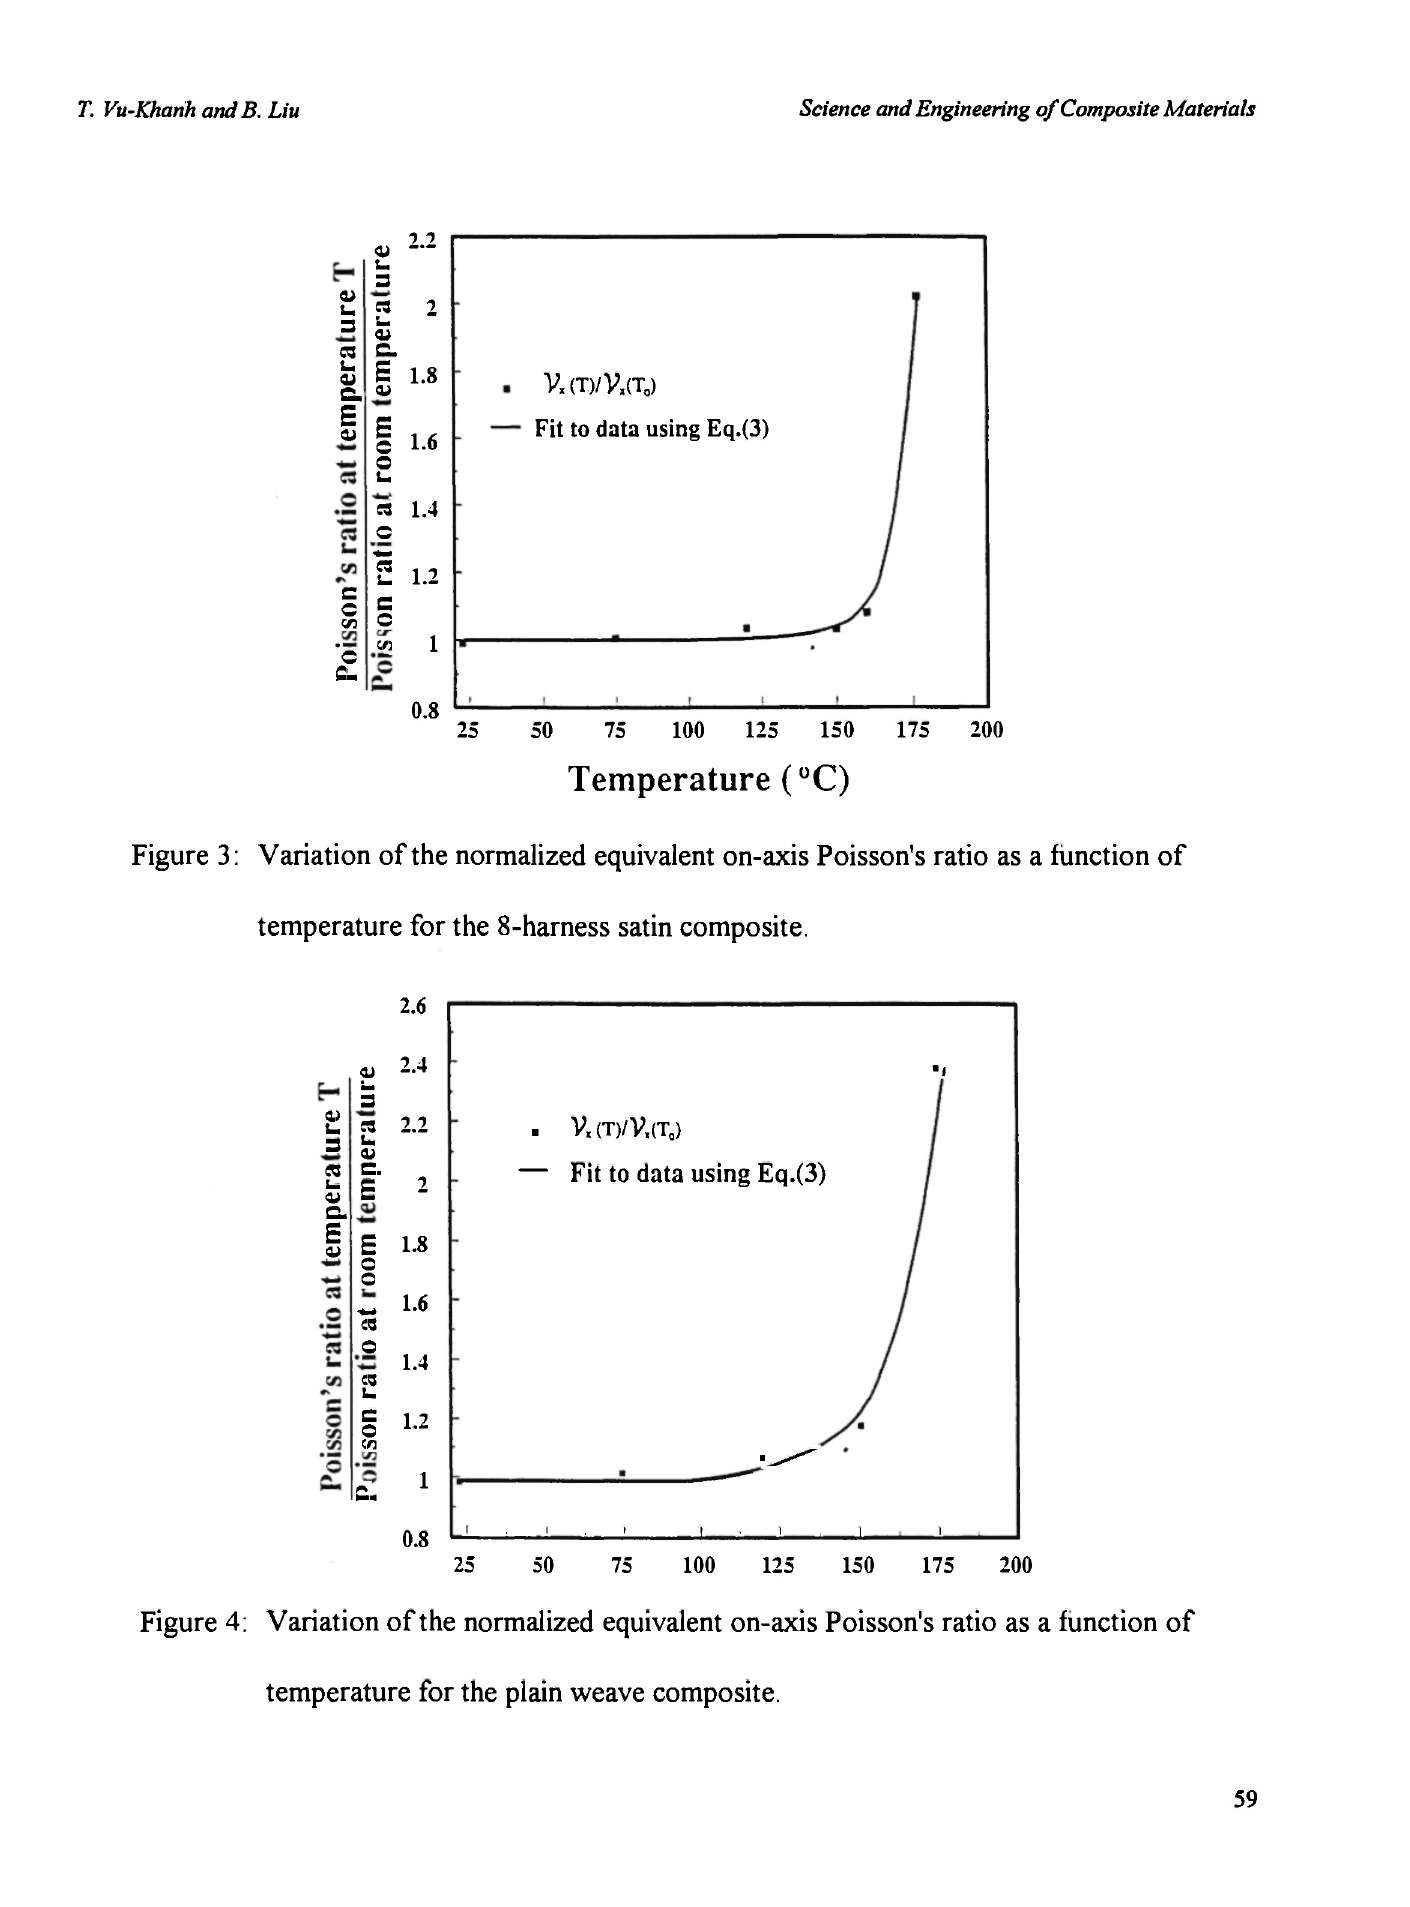
Figure 4: Variation of the normalized equivalent on-axis Poisson's ratio as a function of temperature for the plain weave